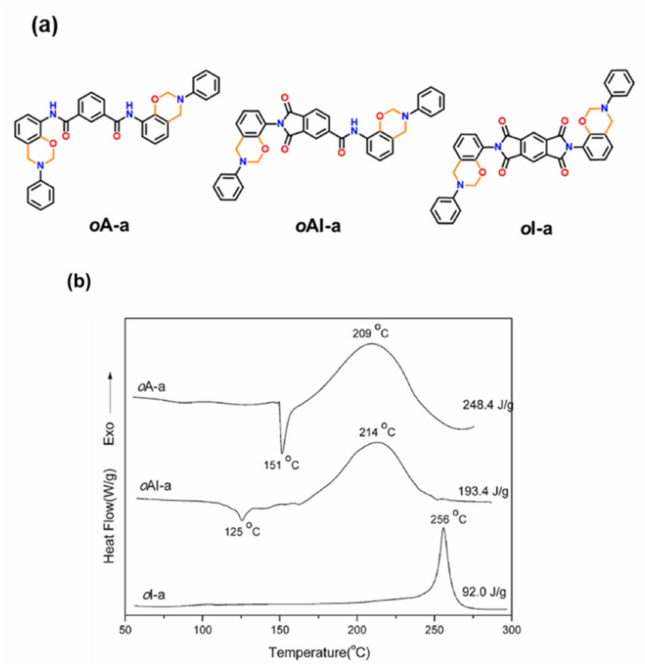
Figure 66. ( a ) Smart benzoxazine monomers having bis- o -amide, asymmetric o -amide-imide and o -bisimide groups and their ( b ) DSC traces [197]. Copyright 2015. Reproduced with permission from Royal Society of